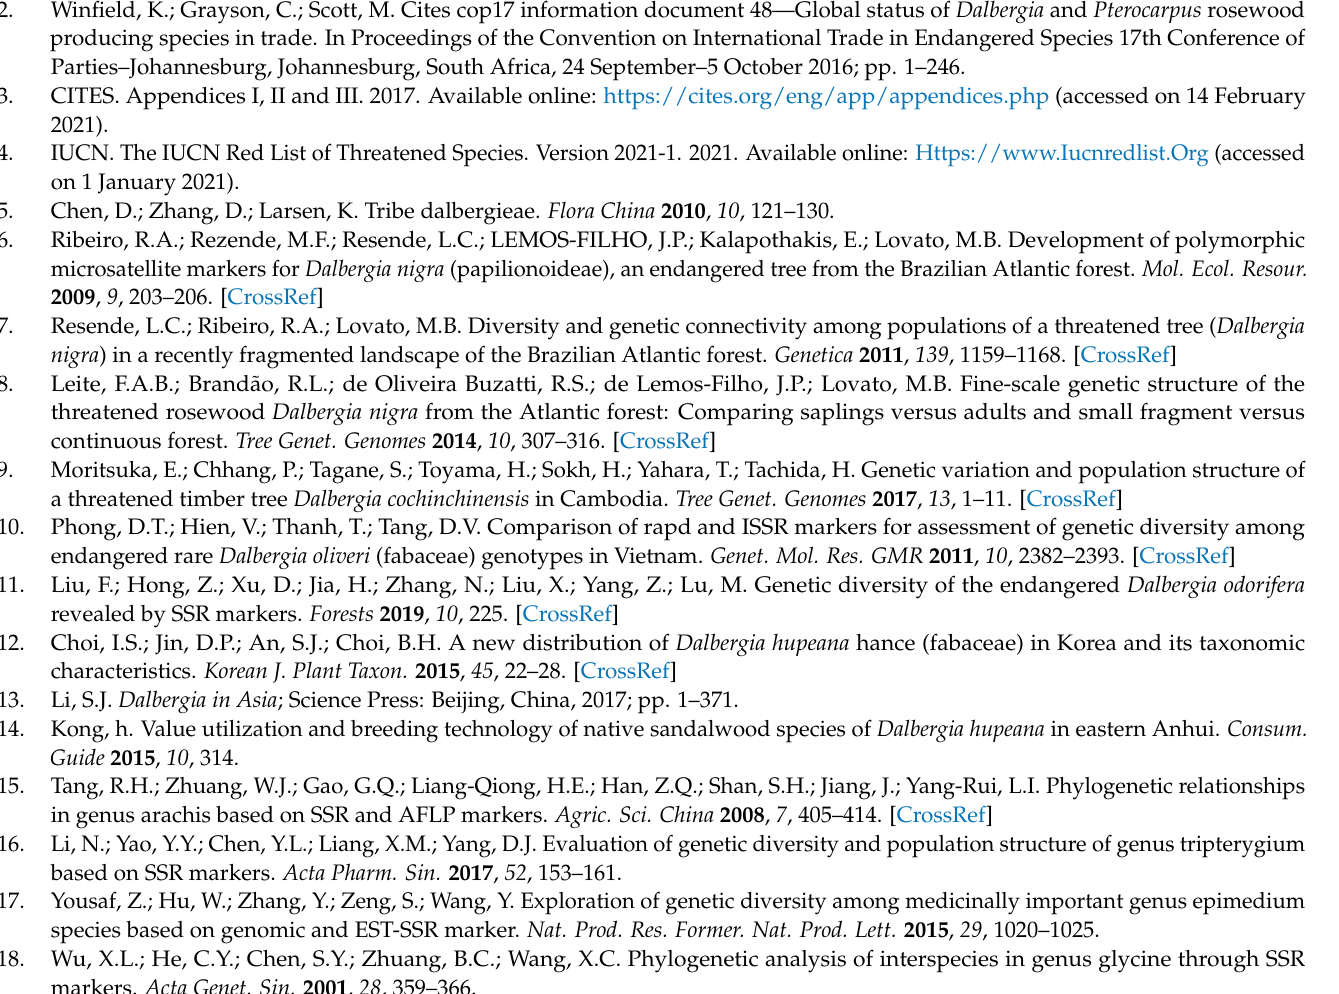
Supplementary Materials: The following are available online at https://www.mdpi.com/article/10 .3390/f12060804/s1, Table S1. Cross-species transferability of developed gSSR markers in different Dalbergia species, Table S2. Parameters of genetic diversity for D. hupeana populations at loci level, Table S3. Parameters of genetic diversity for D. balansae and D. polyadelpha populations at loci level. Another Supplementary Materials includes all the electropherograms and DNA matrix in this